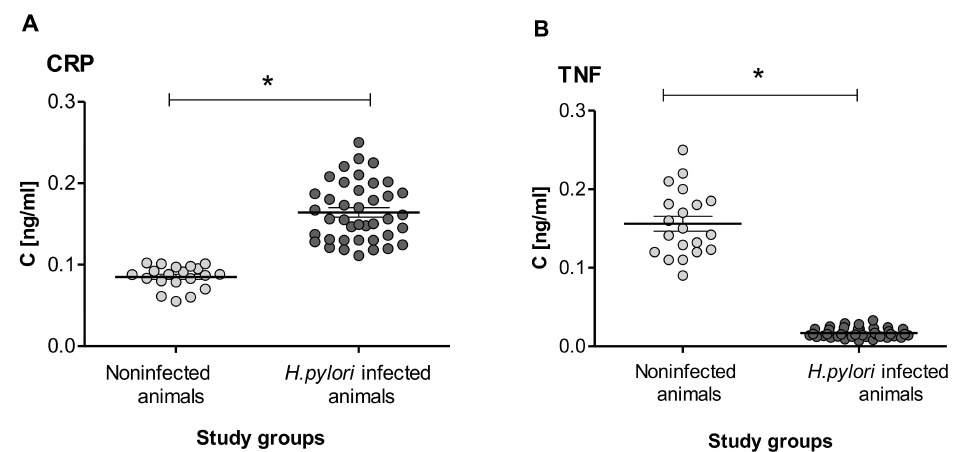
Figure 1. The level of ( A )—CPR and ( B )—TNF in guinea pig sera. Samples collected from nonin- fected guinea pigs (20 per group) and H. pylori infected guinea pigs (40 per group) were examined. The results are presented as mean values ± standard deviation (SD), for each experimental variant. Statistical analysis was performed with the nonparametric Mann–Whitney U test. Statistical sig- nificance * p < 0.05, was shown for H. pylori infected vs. control animals. CRP: C-reactive protein. TNF: tumor necrosis